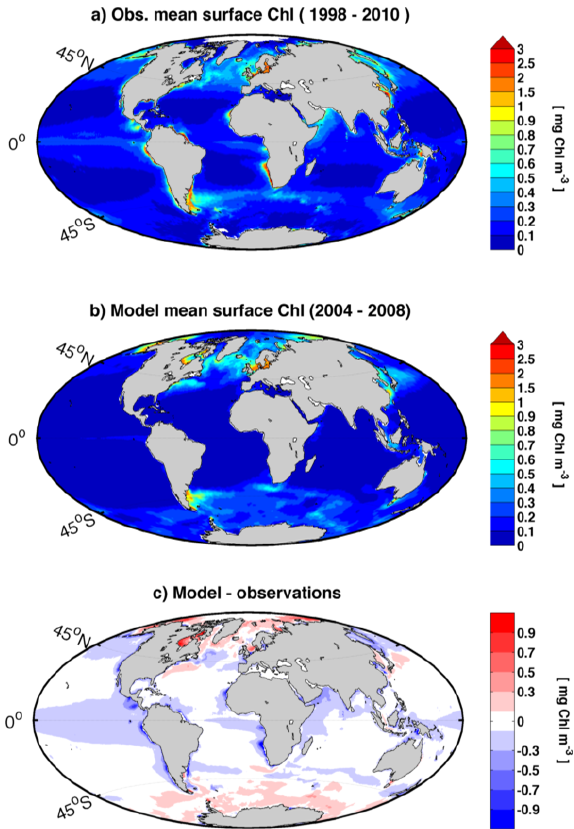
Figure 11. Spatial distribution of mean surface concentrations of chlorophyll a plotted to the scale used by Schneider et al. (2008). (a) Satellite-based estimate (www.globcolour.info). (b) Modelled. (c) Residual: modelled − satellite-based